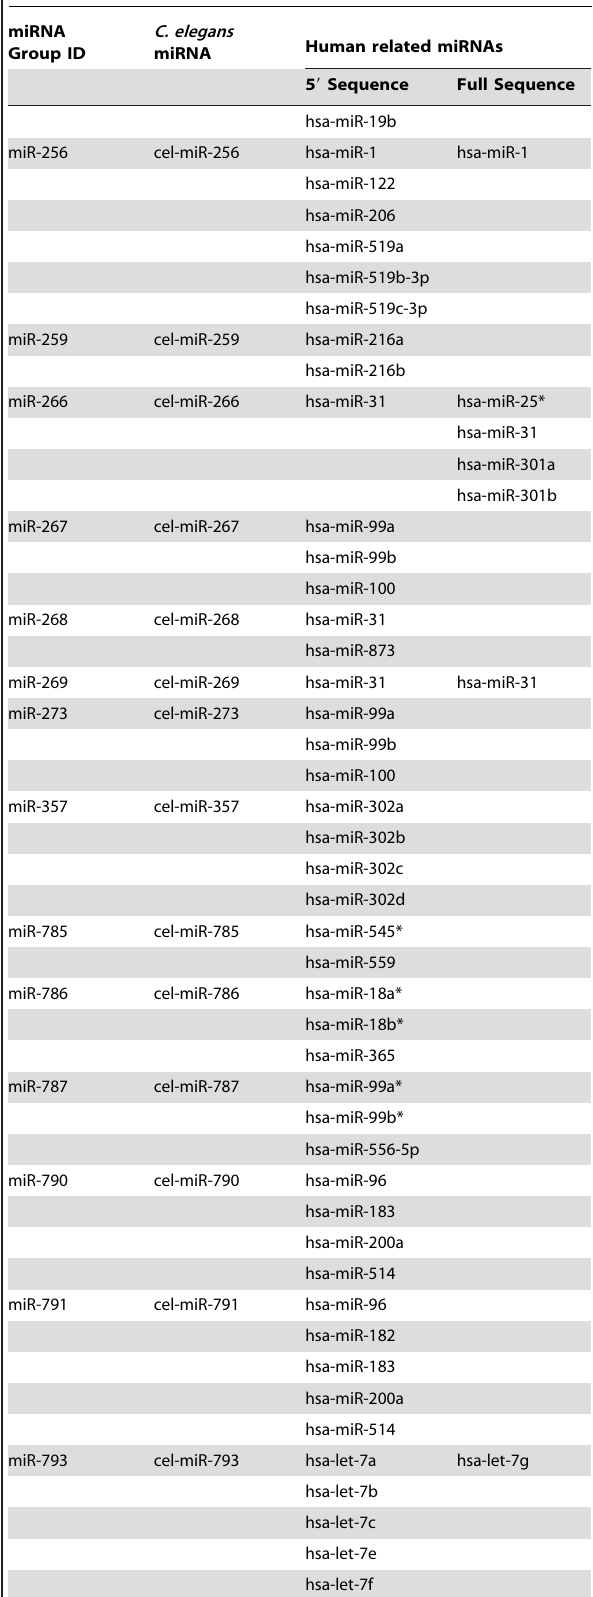
miRNA target sites with perfect complementarity to miRNA 3 9 ends and negligible pairing at the 5 9 end have not been